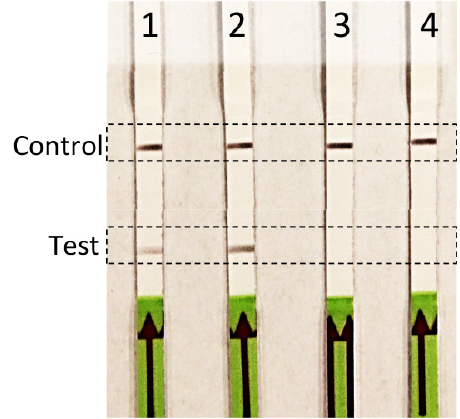
Figure 4. Verification of efficacy for hand-held Rathayibacter toxicus -specific recombinase polymerase amplification (RPA) assay; reaction tubes were enclosed in the palm of the hand (no heat block was required). Four RPA reactions were performed with genomic DNA from two R. toxicus strains (lane 1: SA08-08 and lane 2: WAC7056), one R. rathayi strain (lane 3: ICMP 2579), and water, a non-